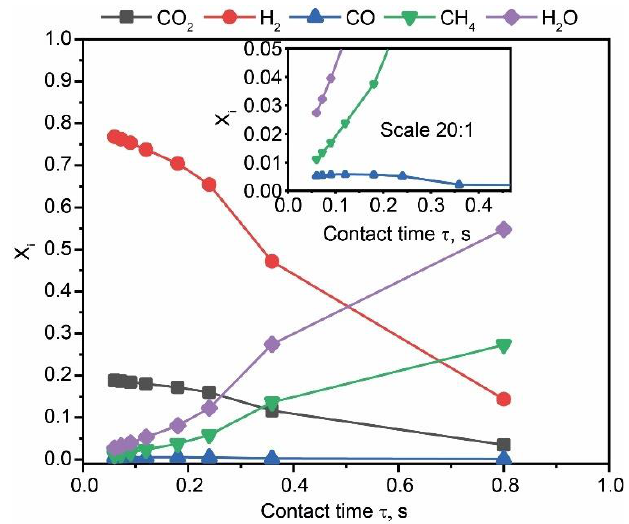
Figure 8. Dependence of the concentration of precursors and products as a function of the contact time. tact